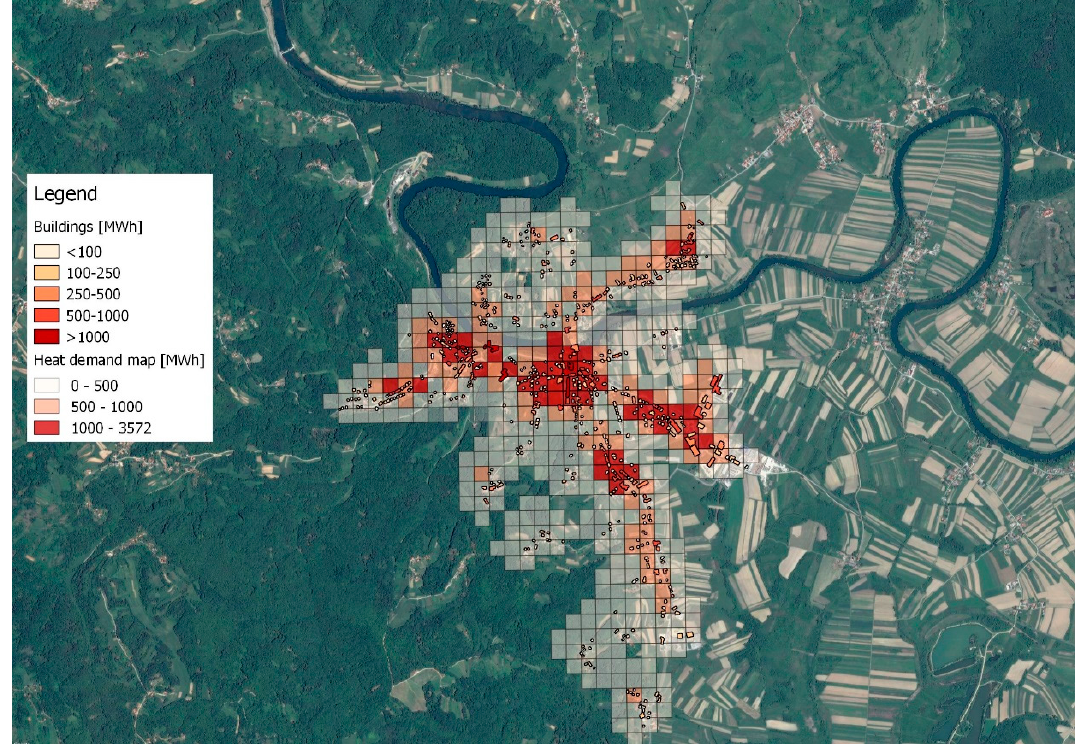
Figure 2. Heat demand map of the city of Ozalj, including the heat demands of each building.